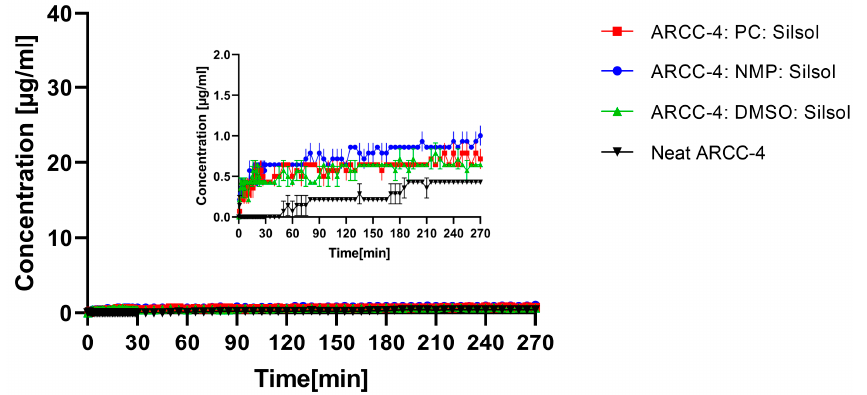
Figure 7. Dissolution profiles of liquisolid formulations ARCC-4: PC: Silsol, ARCC-4: NMP: Silsol, and ▲ ARCC-4: DMSO: Silsol compared to ▼ neat ARCC-4. Non-sink dissolution study was conducted in 20 mL 0.05 M phosphate buffer at pH 6.8 (37 °C, 75 rpm paddle speed).